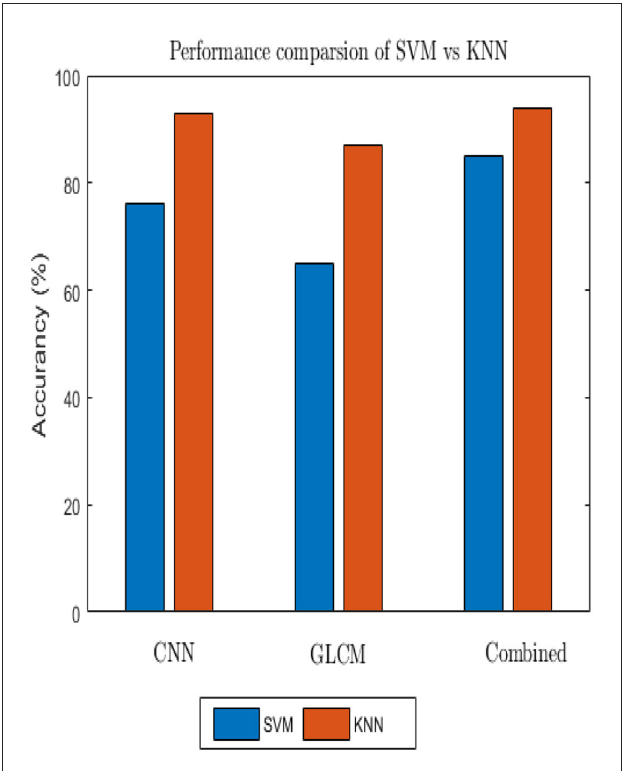
FIGURE11 Comparison of SVM and KNN